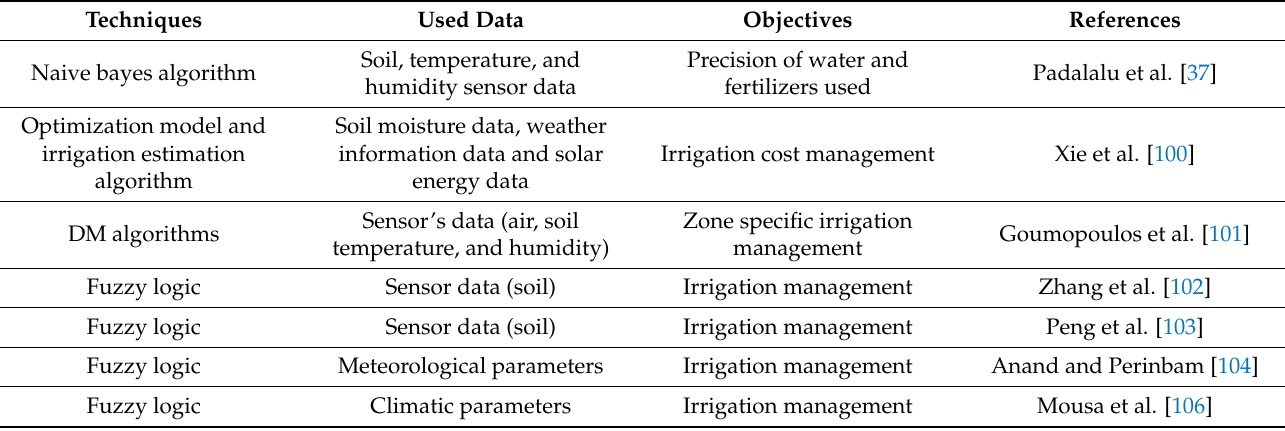
Table 2. Techniques to achieve efficient irrigation goals in smart agriculture